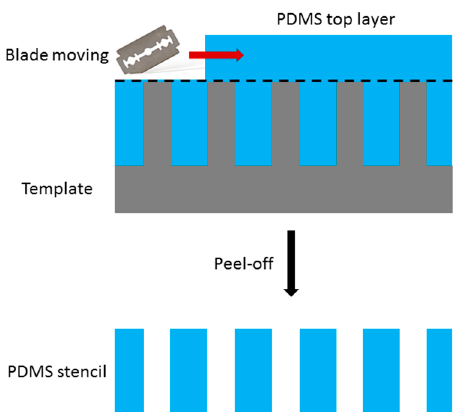
Figure 8. Schematic of fabrication of polydimethylsiloxane (PDMS) stencil by using a doctoral blade.